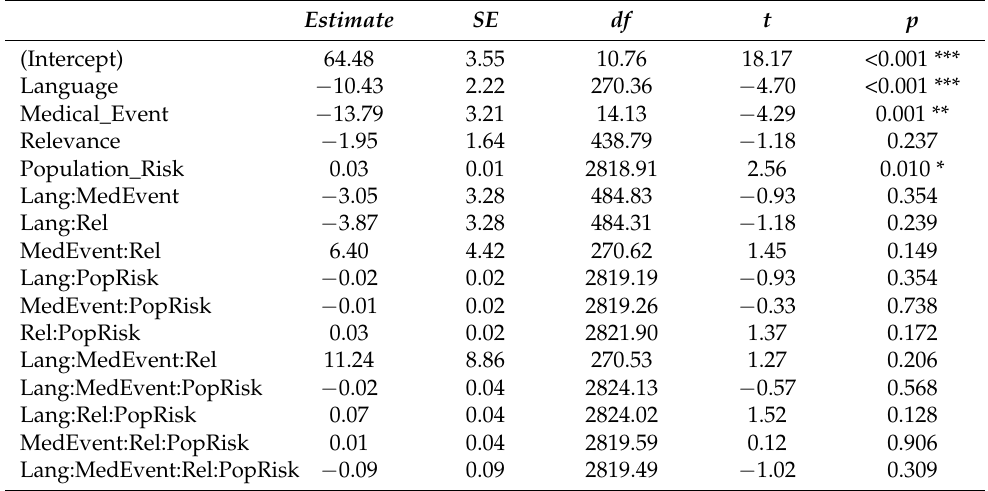
Table A2. Effects of Language, Medical Event, Relevance, and Population Risk on Perceived Negativity.